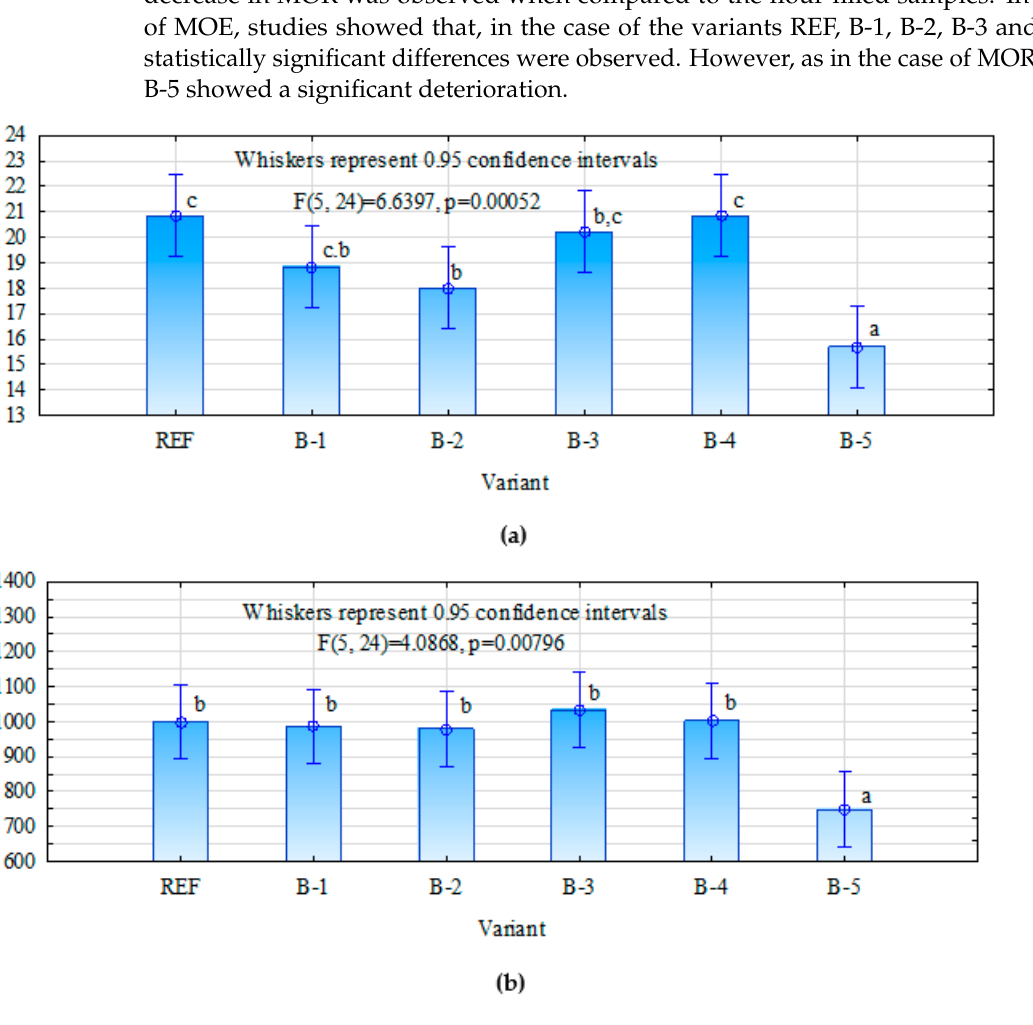
Figure 2. The results of MOR ( a ) and MOE ( b ) tests in perpendicular direction. The lowercase let ‐ ters means homogeneous groups. means homogeneous